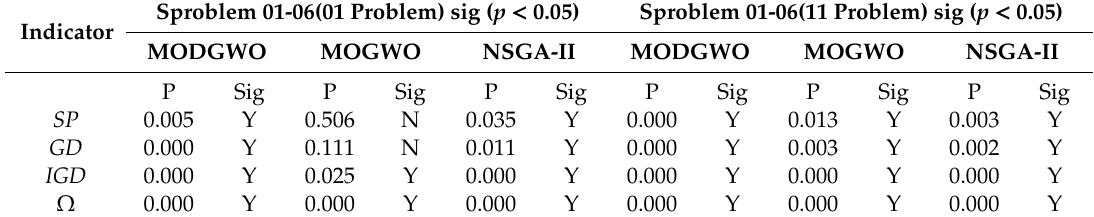
Table 7. Wilcoxon signed rank test (two factories).